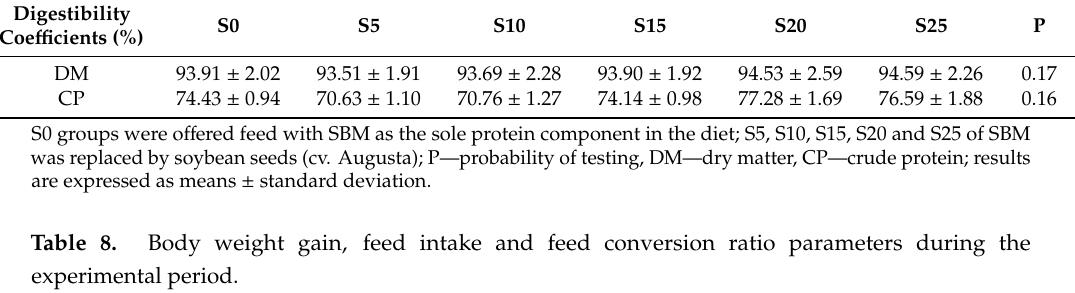
Table 7. Apparent total tract digestibility of dry matter and crude protein in control and experimental diets. Digestibility Coe ffi cients (%)